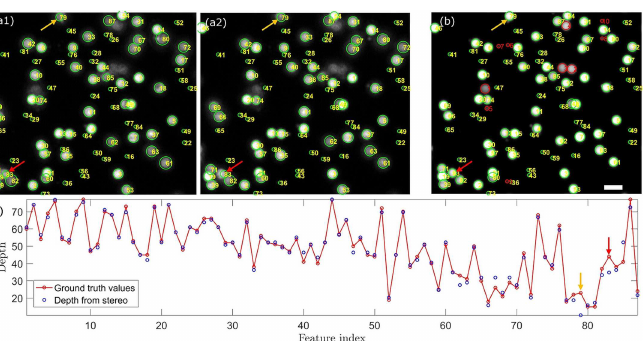
The correspondingcircular objects are also found in the z-projection of the stack (Fig 5d) to determine the groundtruth depths. (d) Comparingthe recovered depths from the stereo-pairand the groundtruth values from the image stack.